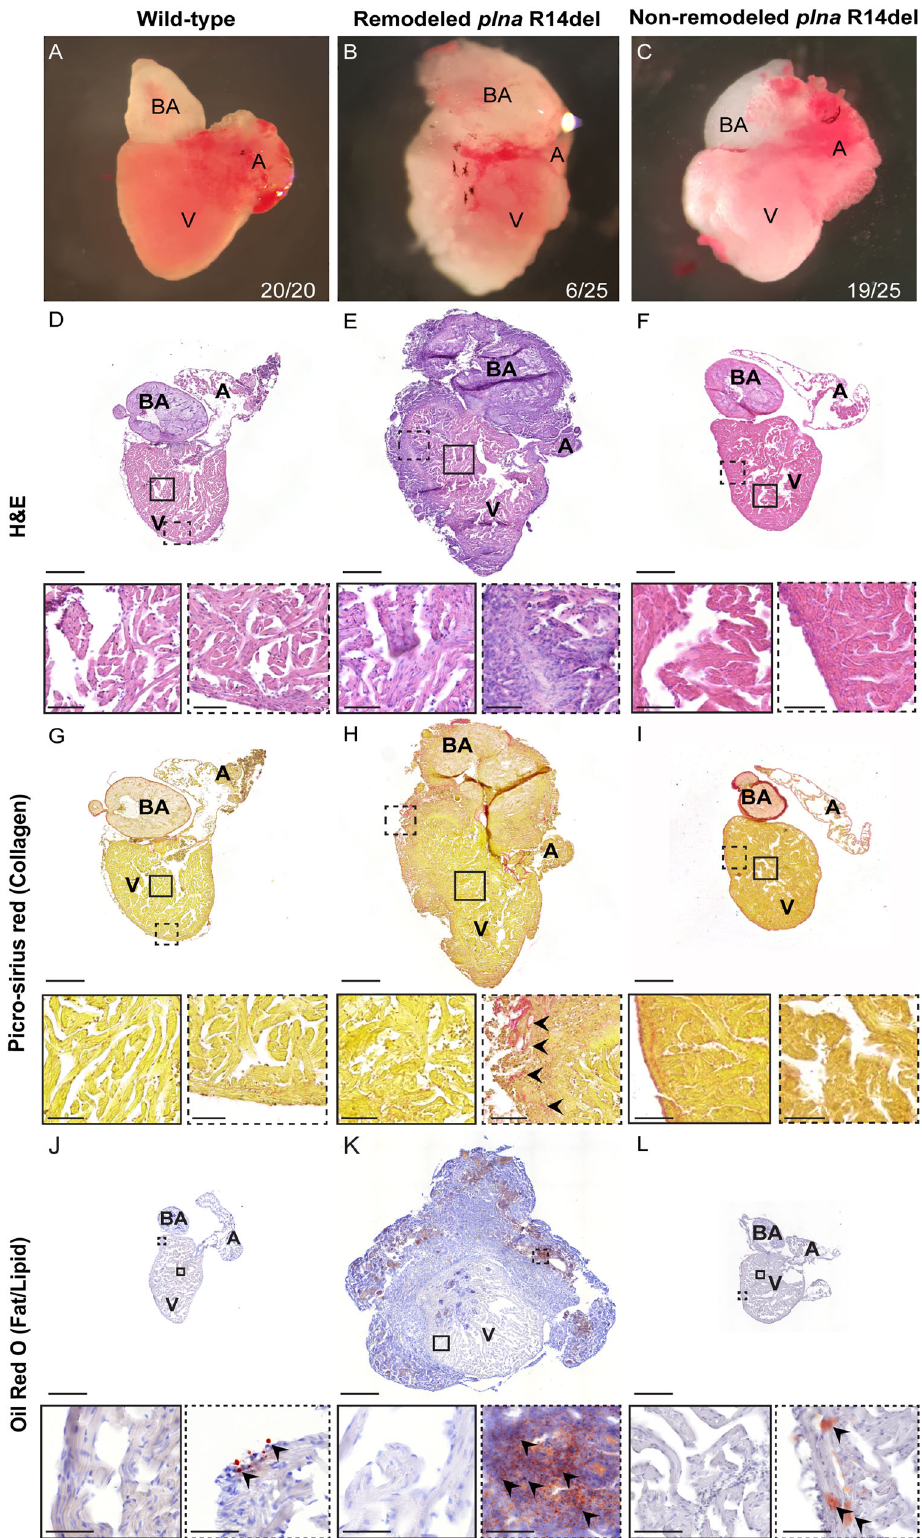
Fig. 1 Structural remodeling of the adult plna R14del zebra fi sh heart. A – C Bright- fi eld images of isolated adult zebra fi sh hearts, 2 years of age: wild-type fi sh, remodeled plna R14del mutant heart and non-remodeled plna R14del heart. D – F Hematoxylin and eosin staining of the three conditions to identify nuclei, with zoom-in at indicated regions. G – I Picro-sirius red staining of collagen deposition for the three conditions, collagen fi bers are shown as red staining. J – L Oil Red O staining for fat/lipid of the three conditions. All stainings were performed on WT n = 3, plna R14del n = 3, two experimental replicates. Zoom-in of each indicated region is included. Images were taken at a magni fi cation of ×20. Scale bars are 200 µ m for whole-heart tile scans and 50 µ m for zoom-in regions. A atrium, V ventricle, BA bulbus